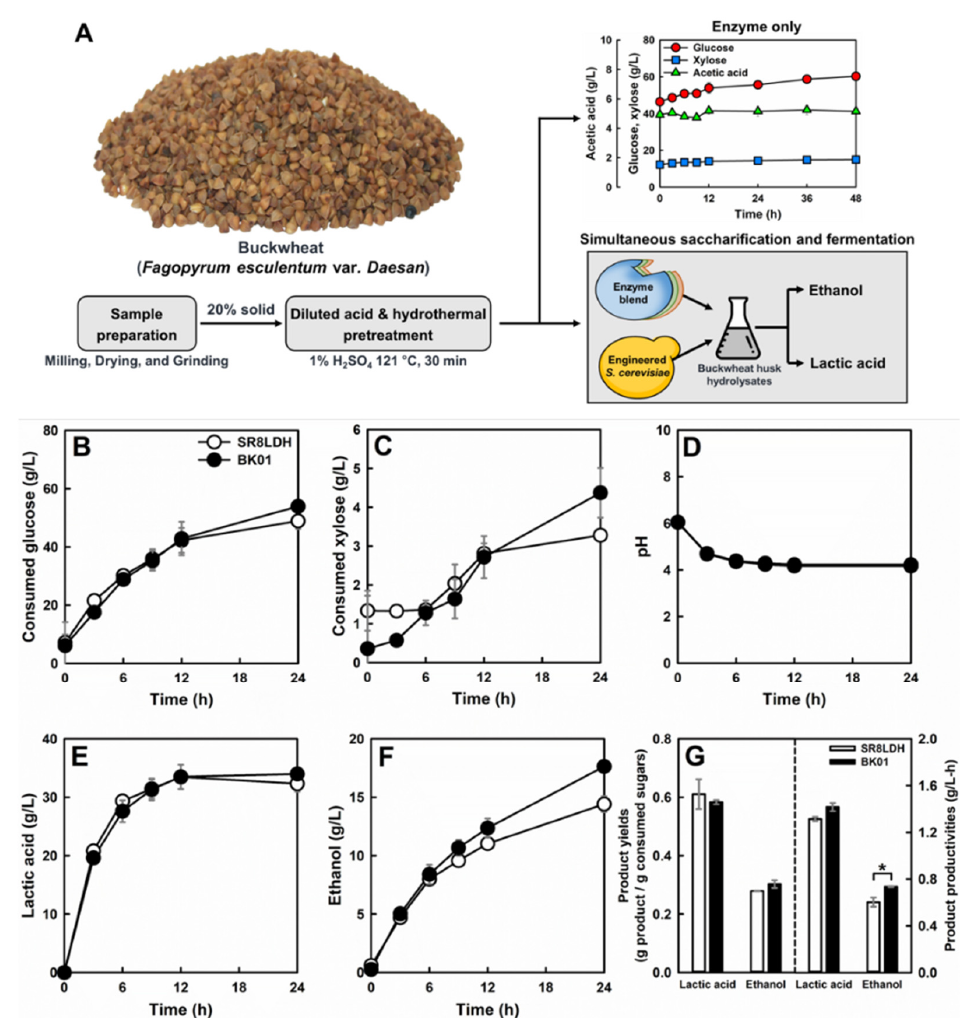
Figure 4. Cellulosic lactic acid production by SR8LDH and BK01 from simultaneous saccharification and fermentation of buckwheat husk hydrolysates ( A ). Consumed glucose ( B ), consumed xylose ( C ), pH ( D ), lactic acid ( E ), ethanol ( F ), and productivities ( G ) were compared. Values represent the mean of three independent experiments. Error bars indicate standard deviation. Asterisks denote statistically significant differences (Student’s t -test, p < 0.05).